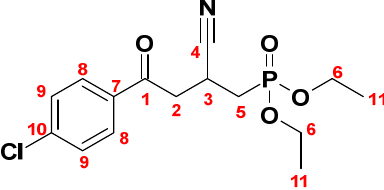
Figure 5. The structure of compound 5e .